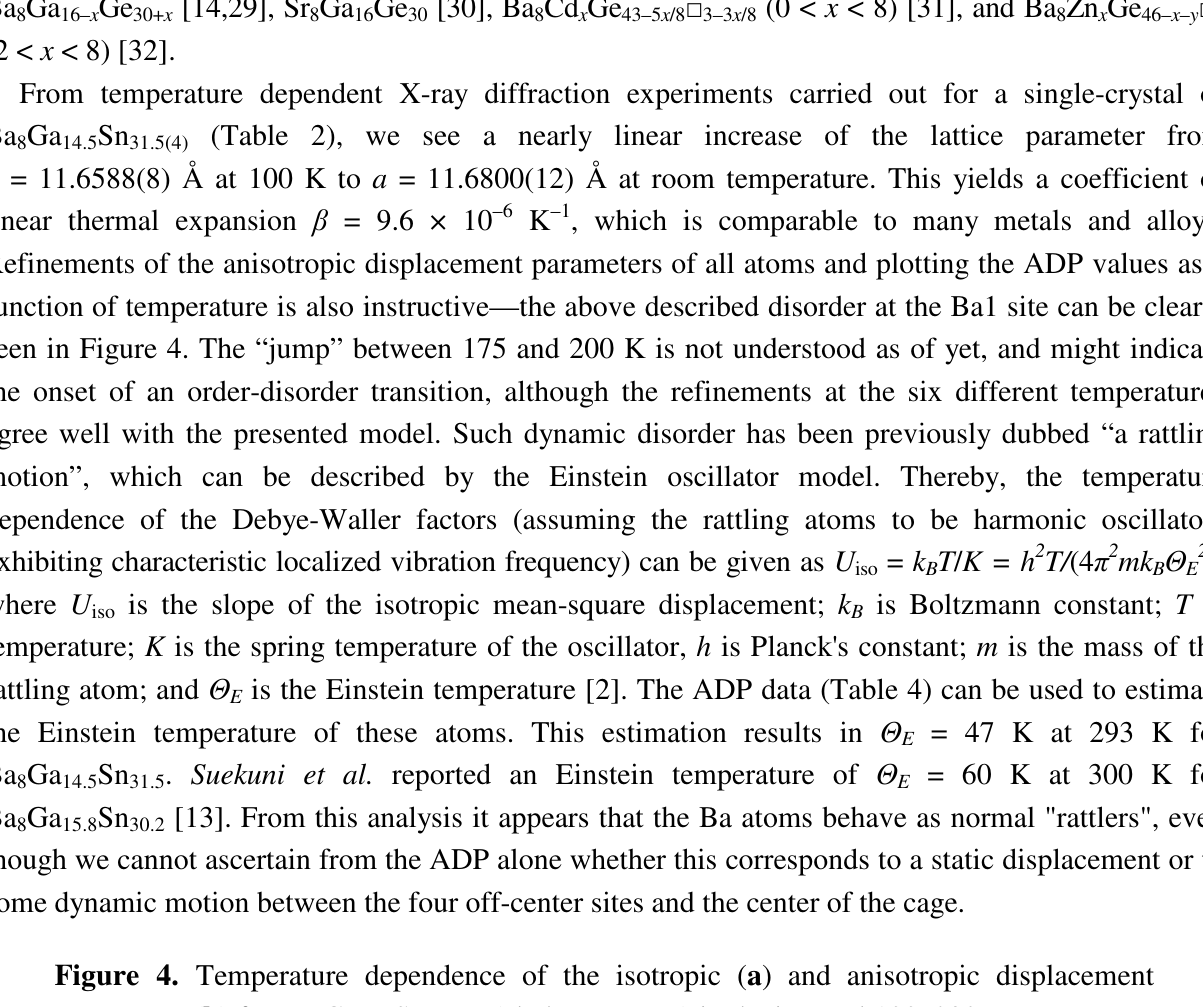
Ga Sn (clathrate type-I) in the interval 100–293 8 14.5 31.5(4)